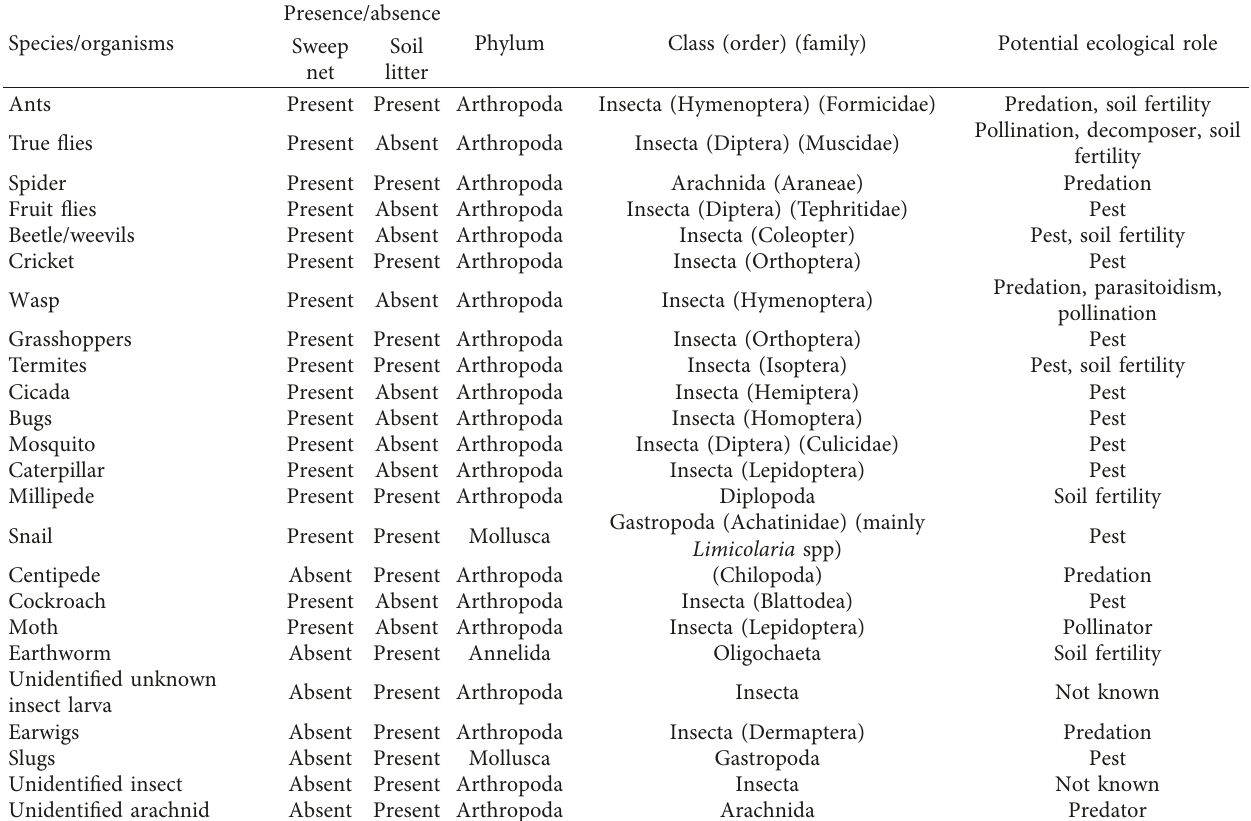
Table 3: Phylum, class, and potential role of species recorded from sweep nets and soil litter from different land-use systems in Fako Division, SW region,